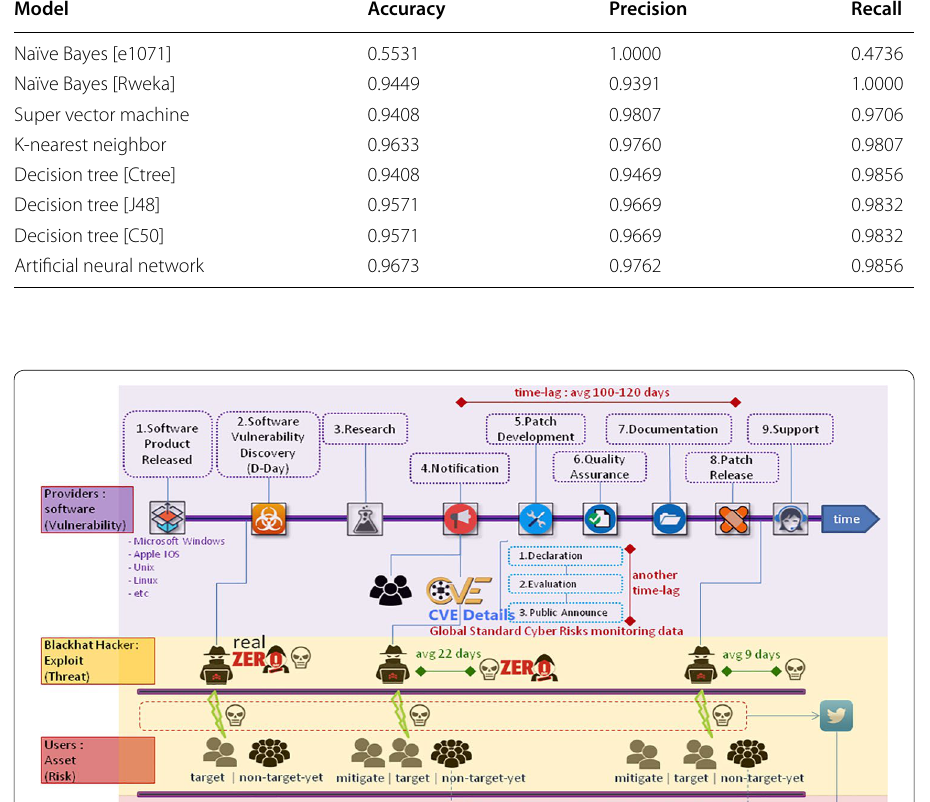
Table 1 Model accuracy comparison and selection